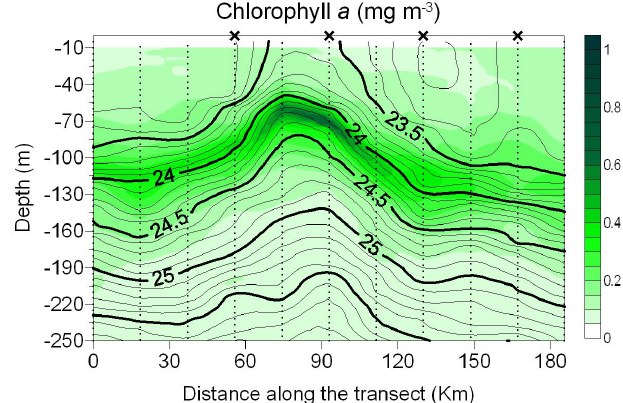
Fig. 3. Vertical section of chlorophyll concentration. The con- tourlines indicate isopycnal surfaces ( σ t values given). The black X’s indicate the positions along the transect of the four casts dis- cussed in this study. The small dots indicate the depths at which the data used to reconstruct the section were collected. The vertical section was reconstructed using all the vertical profiles available for the transect (see Nencioli et al.,